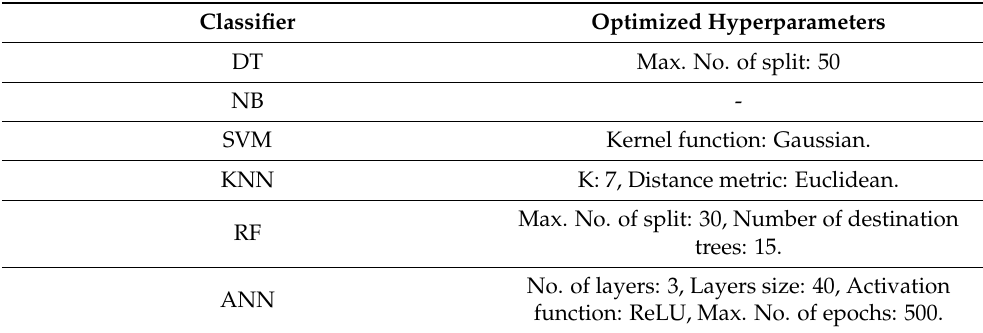
Table 4. Hyperparameters configuration of the proposed